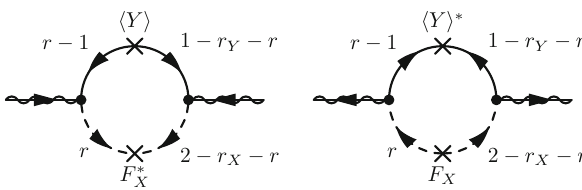
Fig. 4 Possible one-loop diagrams for the gaugino mass from tree- level R-symmetry breaking, with R-charges of messenger components determined from R-charge conservation. The two diagrams are conju- gate to each other, and both should be included as Majorana mass